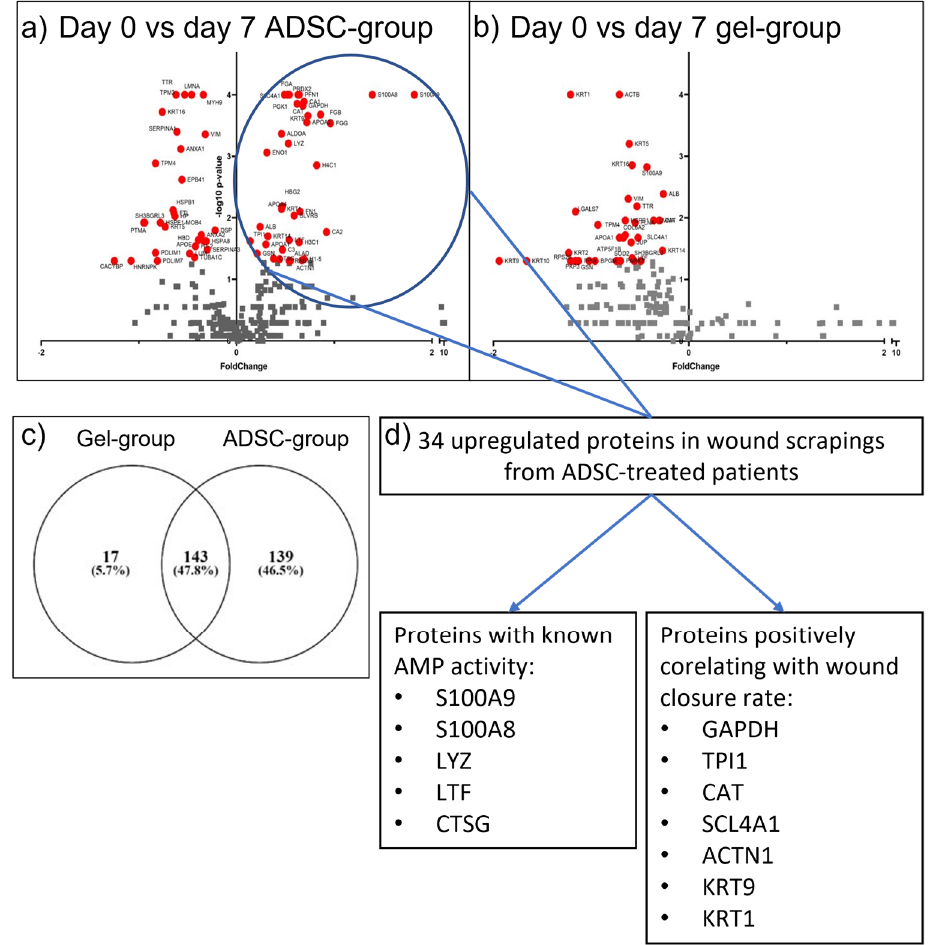
Figure 2. Results of wound scrapings proteomic analysis—Volcano plot of the identified protein intensities: ( a ) ADSC group day 0 vs. day 7; ( b ) Fibrin gel group day 0 vs. day 7; ( c ) Venn diagram comparing identified proteins in the ADSC group and fibrin gel group in both day 0 and day 7; ( d ) Position at volcano-plot and highlighted antimicrobial proteins and proteins correlating positively with wound healing.